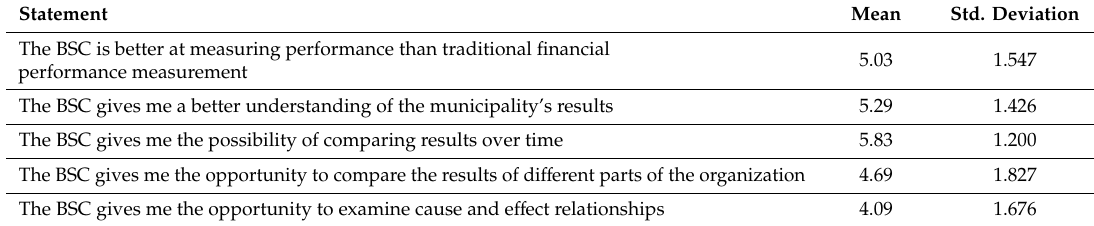
Table 24. The BSC and performance evaluation (N = 36) [Scale: